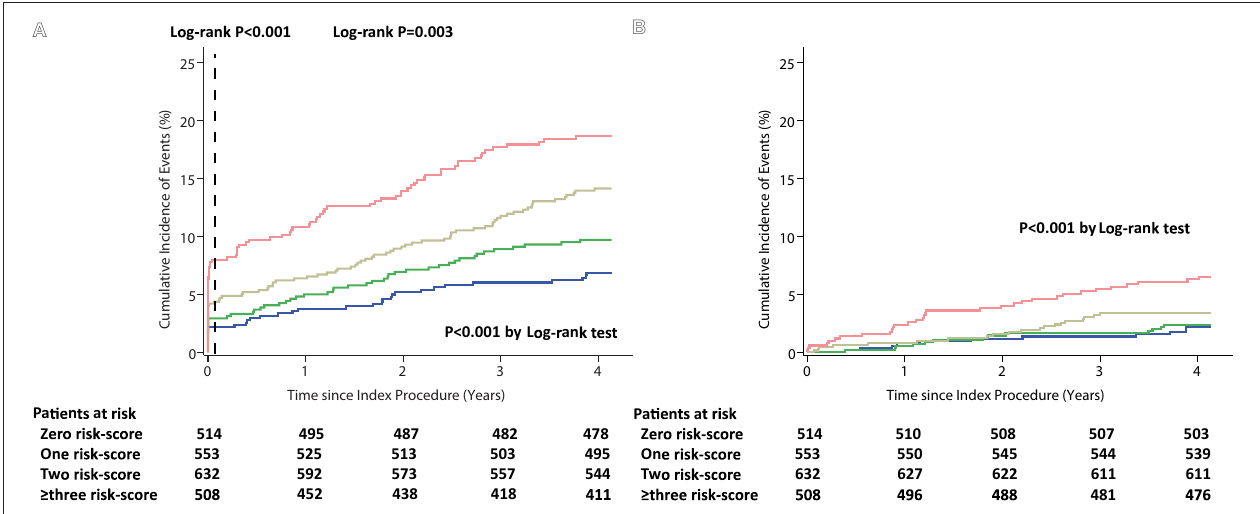
FIGURE 1 | Kaplan–Meier curves during follow-up for 48-month Outcomes among the Cumulative Risk-score Categories. (A) Ischemic events (with 30-day landmark analysis). (B) All-cause Mortality.